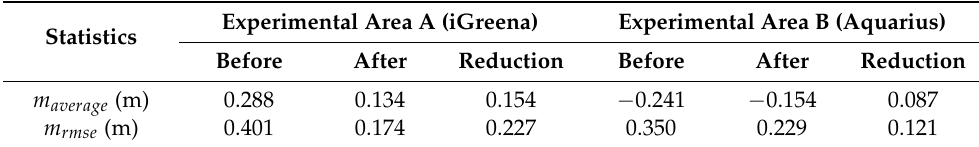
Table 11. Effect comparison before and after laser incident